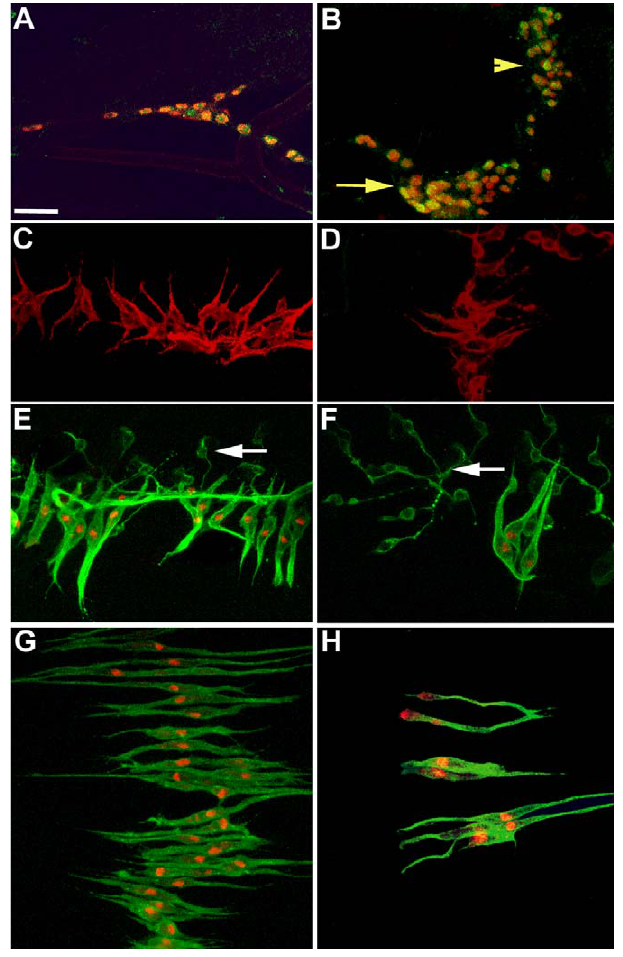
Figure 7. sty and Founder Cells (A and B) sty-lacZ third instar larva (A) and pupa 20 h APF (B) double- labelled with anti-Twi (red) and anti- b -galactosidase (green). (A) A dorsal cluster of Twi-expressing myoblasts, all expressing sty-lacZ . (B) A dorsal cluster (yellow arrow) and a lateral cluster (yellow arrowhead) of myoblasts in a 20 h APF pupa. Not all myoblasts express sty-lacZ at this stage. (C and D) sty-lacZ pupa 28 h APF double-labelled with 22C10 (red) and anti- b -galactosidase (green). sty-lacZ is not expressed in the dorsal (C) or lateral (D) set of founders. (E–H) Pupae 28 h APF (grown in 29 8 C) double-labelled with 22C10 (green) and anti- b -galactosidase (red). (E and G) duf-lacZ pupae showing sets of dorsal (E) and lateral (G) founders. (F and H) 1151/duf-lacZ; UAS- sty/ þ pupae showing decreased number of founders in the dorsal (F) and lateral (H) hemi-segments. White arrows in (E) and (F) indicate 22C10- labelled neuronal branching. Anterior is at top; dorsal midline is at